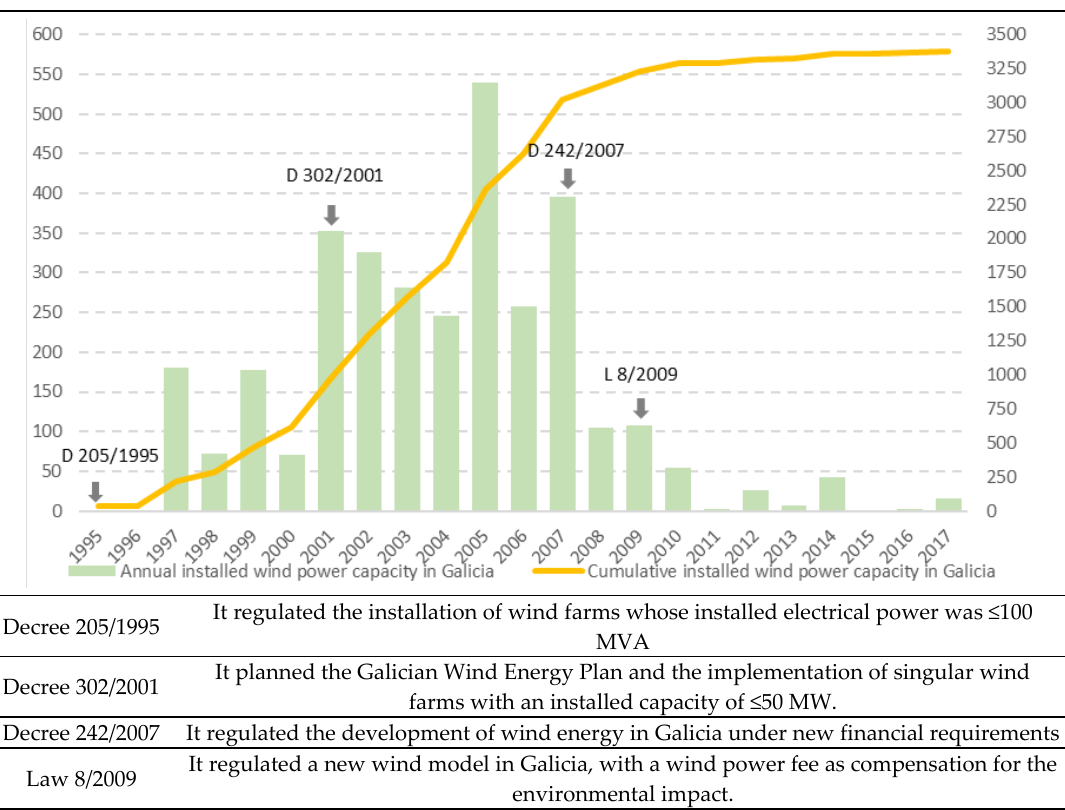
Table 3. Types of wind farms installed in Galicia (1995–2017) elaborated from